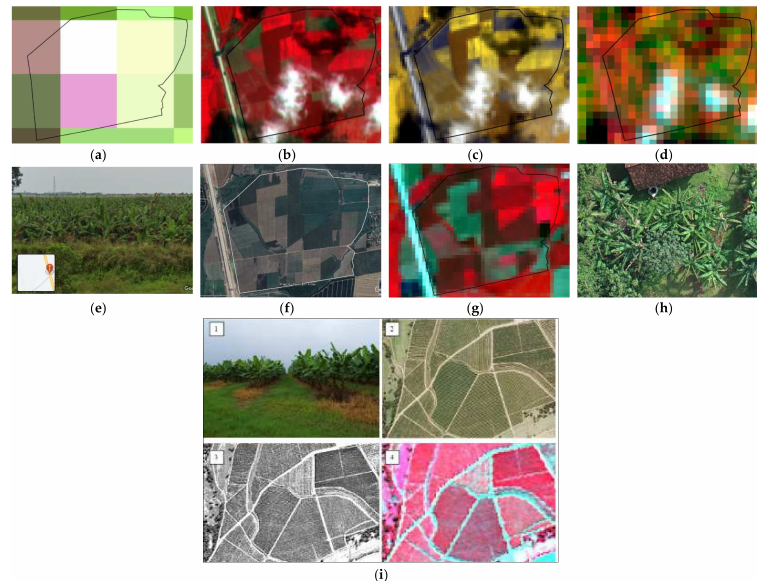
Figure 1. A comparison of the spatial resolution of MODIS ( a ), Sentinel-2 data with pixel size at about 10 m × 10 m, 20 m × 20 m, and 60 m × 60 m, ( b – d ), field condition and coverage area using Google Earth ( e , f ), Landsat 8 ( g ) of a banana plantation in Lampung Tengah regency, Lampung-Indonesia, and an aerial photograph ( h ) of individual banana herbs in the Gadingrejo village, Pringsewu-Lampung, and SPOT-5 (cid:48) s observation in Northern Australia ( i1 – i4